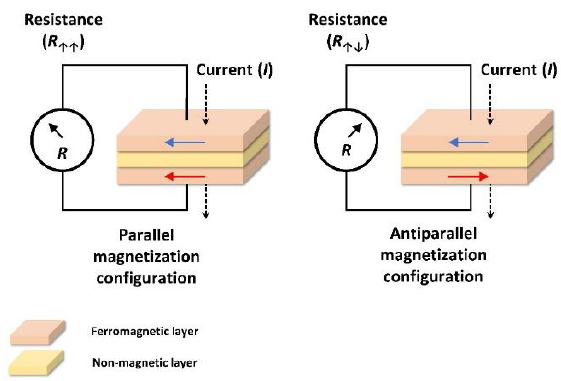
Figure 2. Schematic diagram of giant magnetoresistance (GMR).